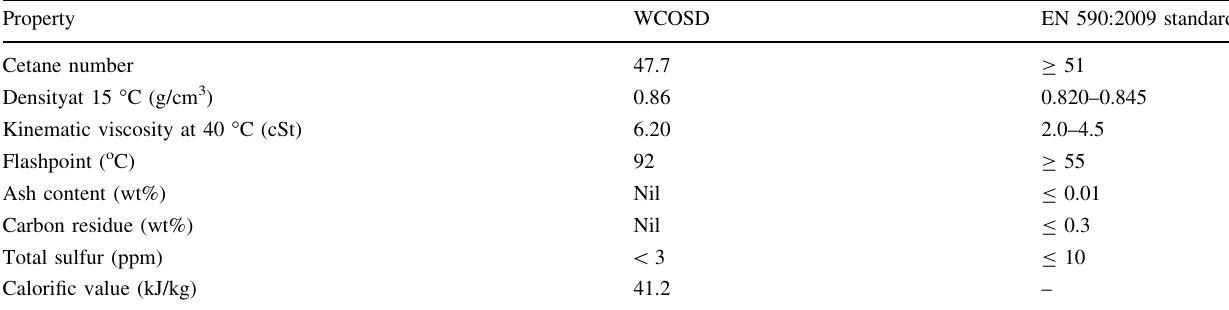
Table 3 Fuel properties of WCOSD compared to EN 590:2009 standard specifications of diesel fuel Property